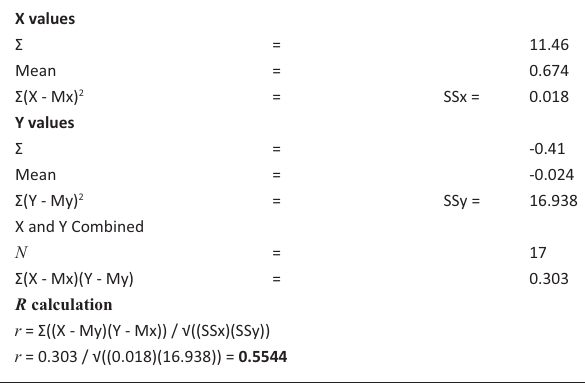
FIGURE 3: Pearson correlation coefficient between the normalised difference vegetation index and standardised precipitation index at standardised precipitation index-3 time